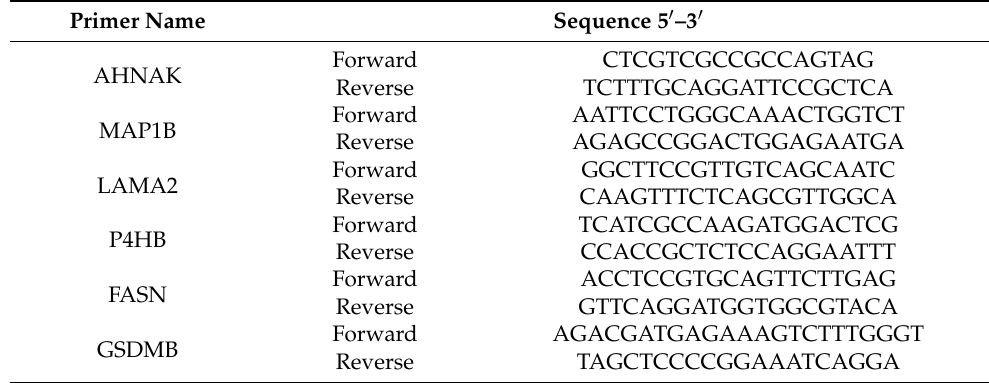
Table 2. Primers used in the present